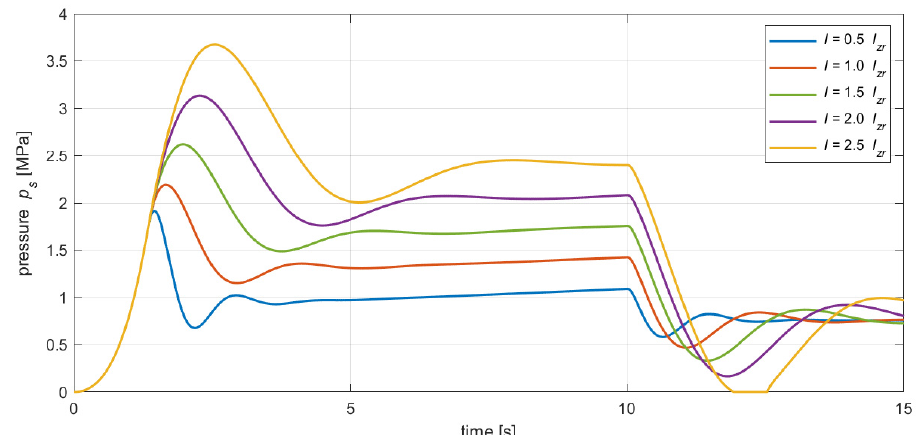
Figure 12. Result of simulation of the waveform of pressure on the motor 𝑝 (cid:3046) for various moments of inertia of the system ( 𝐾 (cid:3017) = 0.015, 𝑇 (cid:3010) = 0.75 s) .